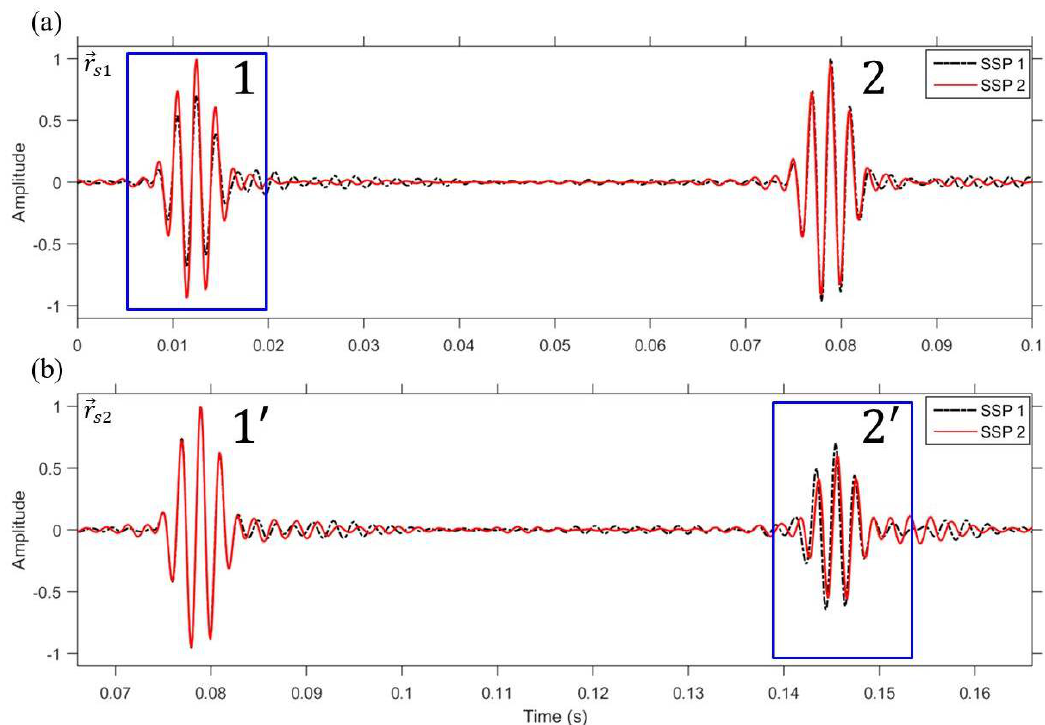
Figure 3. (Color online) Simulated VSA-based multiple TR focusing using superposition method. The simulated time series are normalized with respect to its own maximum. ( a ) Time series at (cid:126) r (cid:126) r s 2 = (2.3 km, 50 m). The residual signal (denoted by a rectangular s 1 = (2.2 km, 50 m); ( b ) Time series at box) is clearly observed for the cases of isovelocity with a sound speed of c = 1500 m/s (SSP 1, dot-dashed) and downward-refracting SSP (SSP 2,